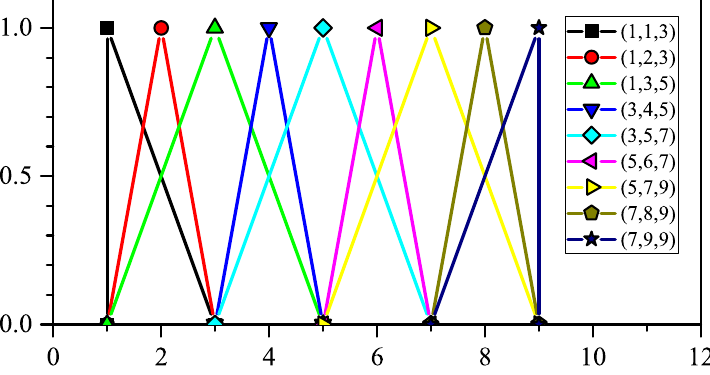
Figure 3. Graphic representation of TFNs. Step 3. Matrix consistency review.